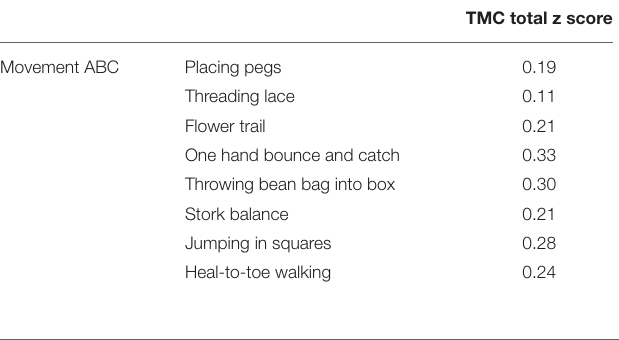
TABLE 3 | The intercorrelation between total score TMC and the eight tasks from MABC.